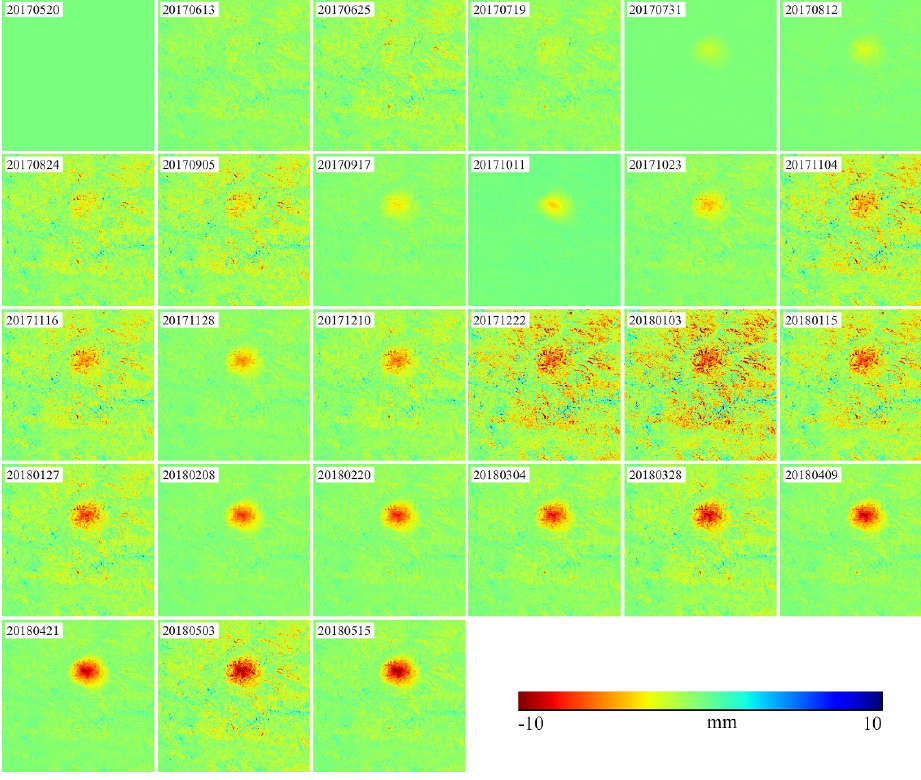
Figure 6. Time series deformation fields calculated by the SBAS algorithm.